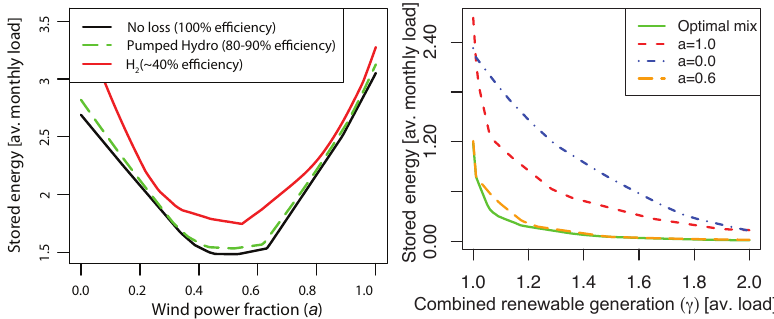
Fig. 2. Left panel: Comparison of the maximum stored energies for an idealized storage (black), pumped hydro (green) and hydrogen storage (red) as a function of the wind fraction (a). The unit of the stored energy is in average monthly load. Right panel: Storage energy capacity as a function of the excess generation ( ! ) and for different shares a of wind power generation (a). The storage efficiencies have been set to 1.